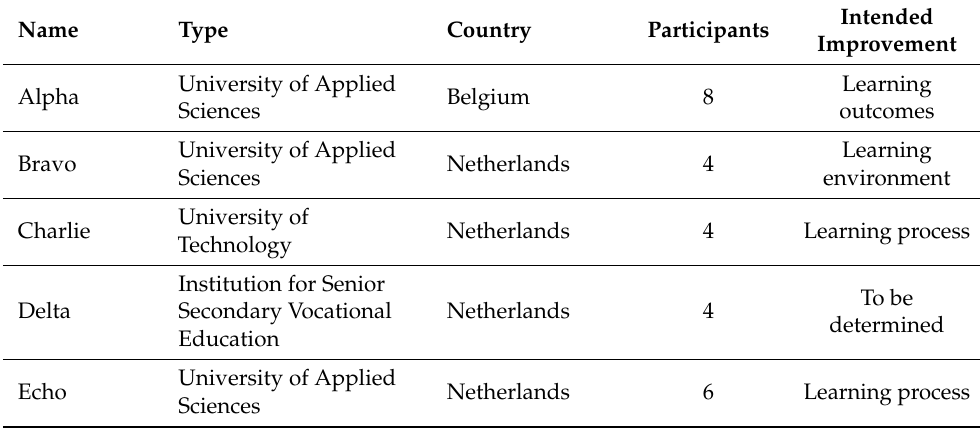
Table 2. Overview of participating